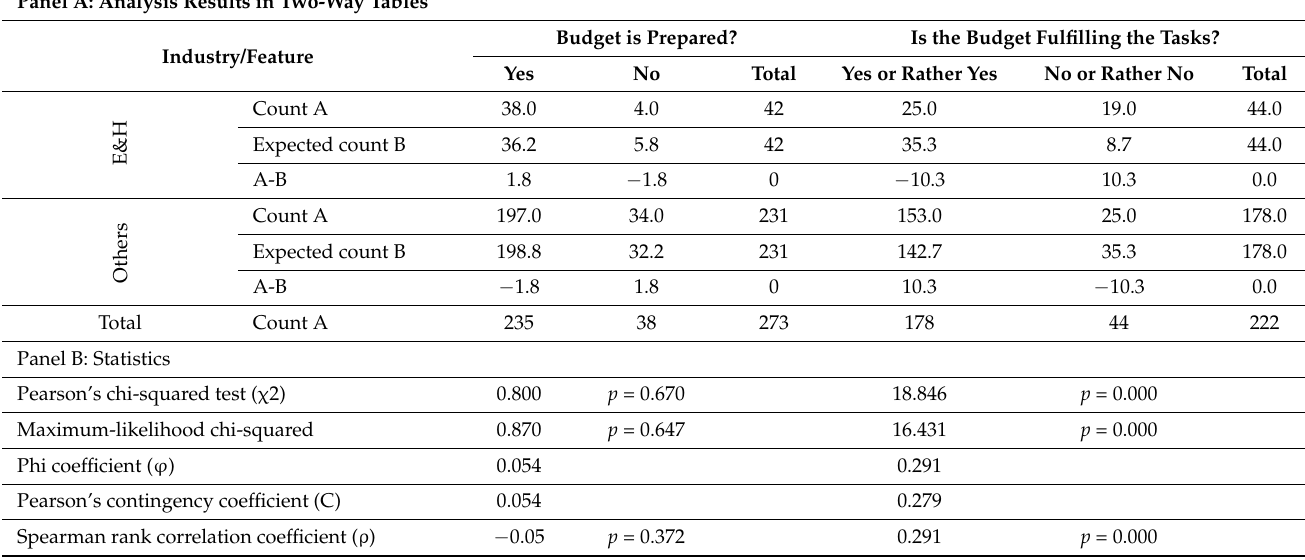
Table 10. Implementation of budgeting processes and assessment of their